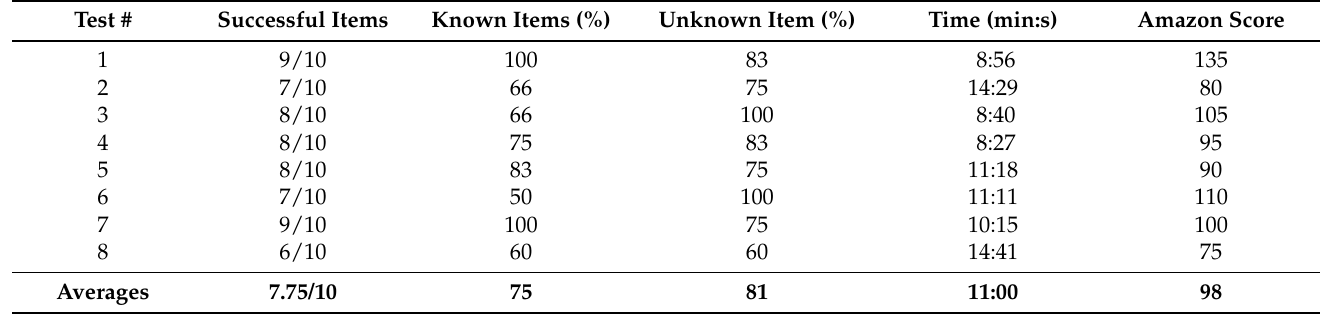
Table 4. Summary data of conducted